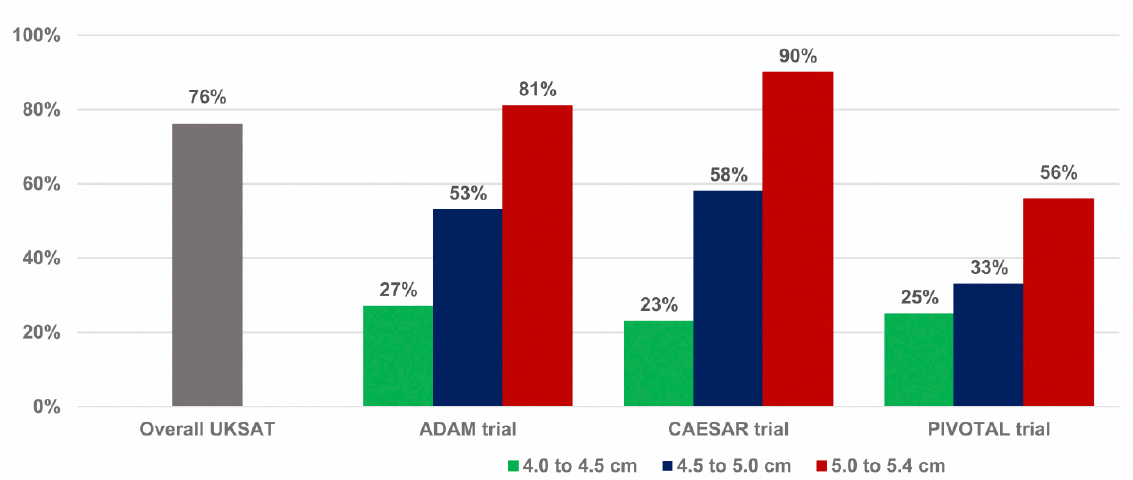
Figure 2. Eventual repair rates for abdominal aortic aneurysms in the surveillance cohorts of the UKSAT 23 , ADAM 24 , CAESAR 25 , and PIVOTAL 26 trials. The reasons for the eventual repairs included rupture, the onset of back pain or local tenderness, rapid growth on consecutive ultrasound scans or enlargement to a size exceeding the trial protocol, and patient preference. ADAM, Aneurysm Detection and Management trial; CAESAR, Comparison of surveillance versus Aortic Endografting for Small Aneurysm Repair trial; PIVOTAL, Positive Impact of endoVascular Options for Treating Aneurysms earLy trial; UKSAT, United Kingdom Small Aneurysm